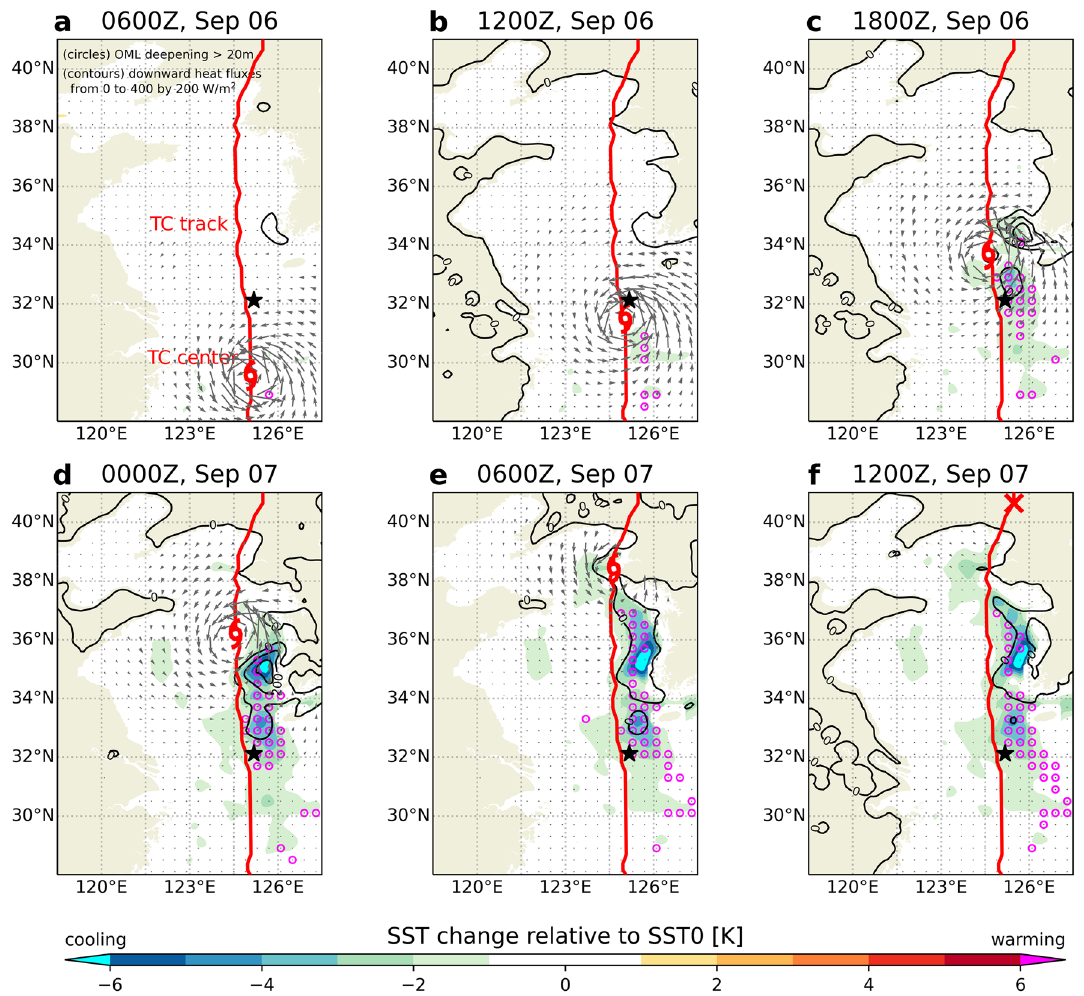
Figure 3. Horizontal distribution of sea surface temperature (SST) changes (shaded) relative to initial condition for the CPL simulation at 00Z on September 6 for the analysis domain every 6 h. The contours and unfilled circles denote downward (positive) turbulent heat fluxes only and OML deepening exceeding 20 m, respectively. Grey arrows denote wind stress vector (N/m 2 ). Red lines and typhoon symbols indicate TC tracks and TC center location. The black star indicates the location of the Ieodo